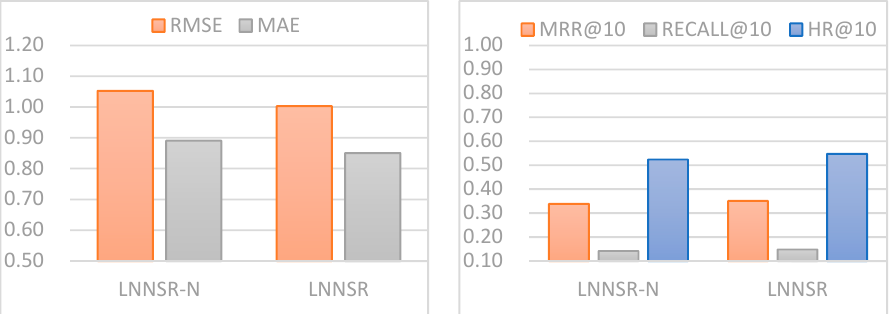
Figure 8. Effect of granularity distribution proportion weights of node’s attributes on the Book- Crossing dataset.